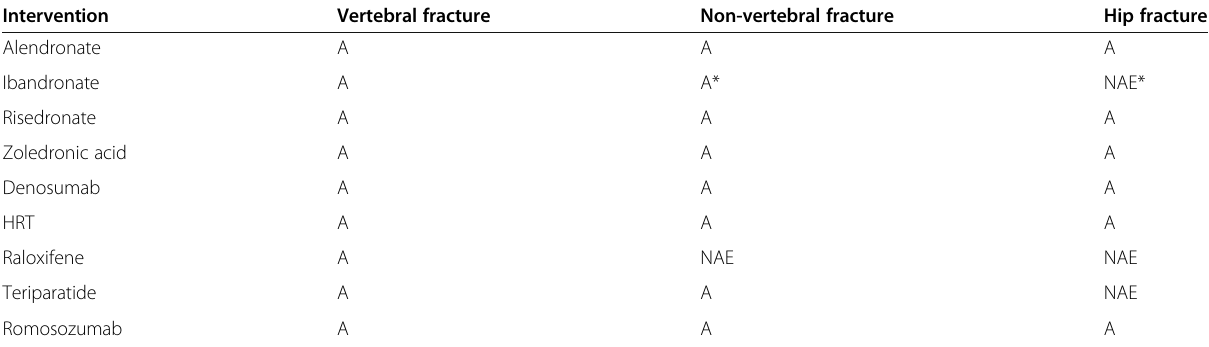
Table 3 The anti-fracture efficacy of the approved therapies for postmenopausal women with osteoporosis when given with calcium and vitamin D